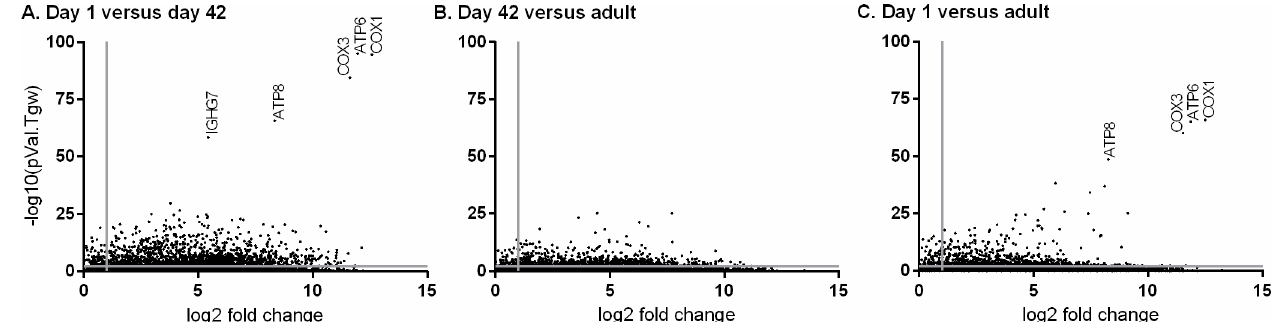
Fig 2. Differential gene expression between day 1 foal, day 42 foal, and adult horse samples. Gene expression levels were compared between groups and plotted with log2 fold expression on the x-axis and–log10 p-value on the y-axis. Gray lines show threshold for levels of differential expression (fold change (cid:21) 2) and significance (p-value < 0.01). A) Comparison of gene expression from day 1 versus day 42 foal samples; B) comparison of gene expression from day 42 foal versus adult samples; and C) comparison of gene expression from day 1 foal versus adult samples.